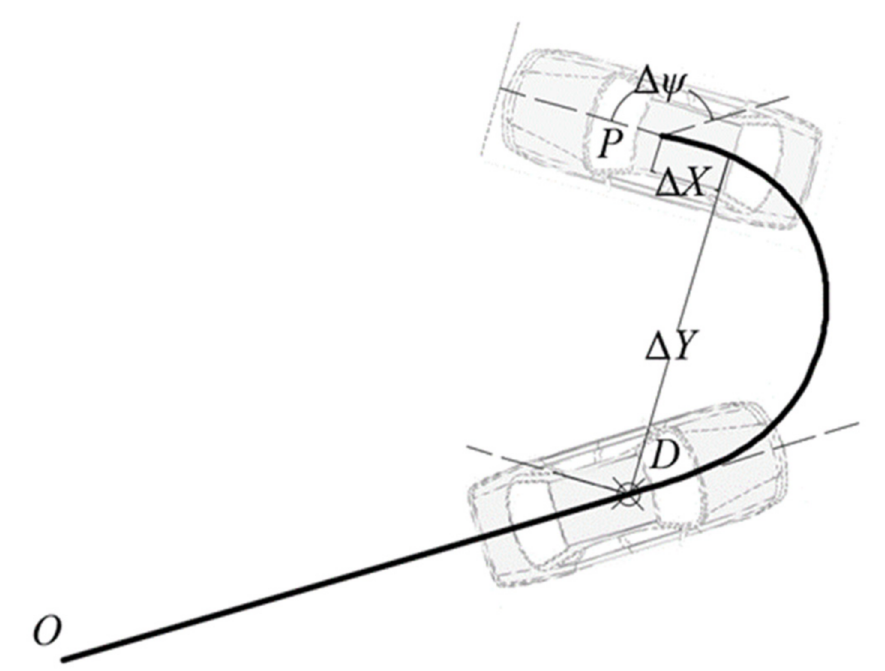
Figure 1. Schematic diagram of drift